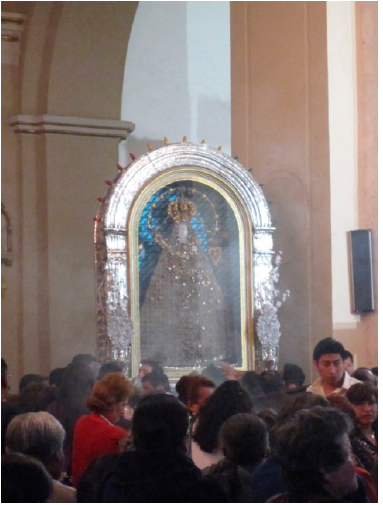
Figure 4. Worship of the Virgin (photo: Andrea Nicklisch). Religions 2018 , 9 , x FOR PEER REVIEW